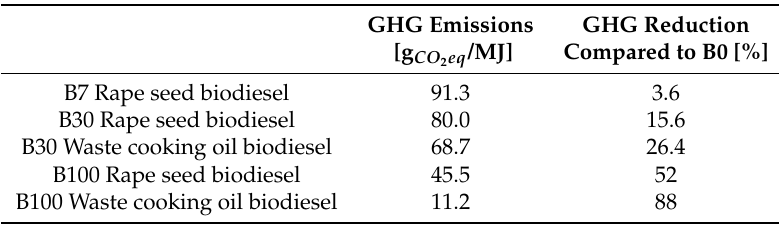
Table 1. The GHG emissions for the cultivation, processing, transport and distribution of biofuels decrease as the volume concentration of RME increases. The reduction in WTT GHG emissions when shifting from pure fossil diesel (B0) to pure RME biodiesel (B100) or to pure UCOME biodiesel (B100) is 52% and 88%, respectively